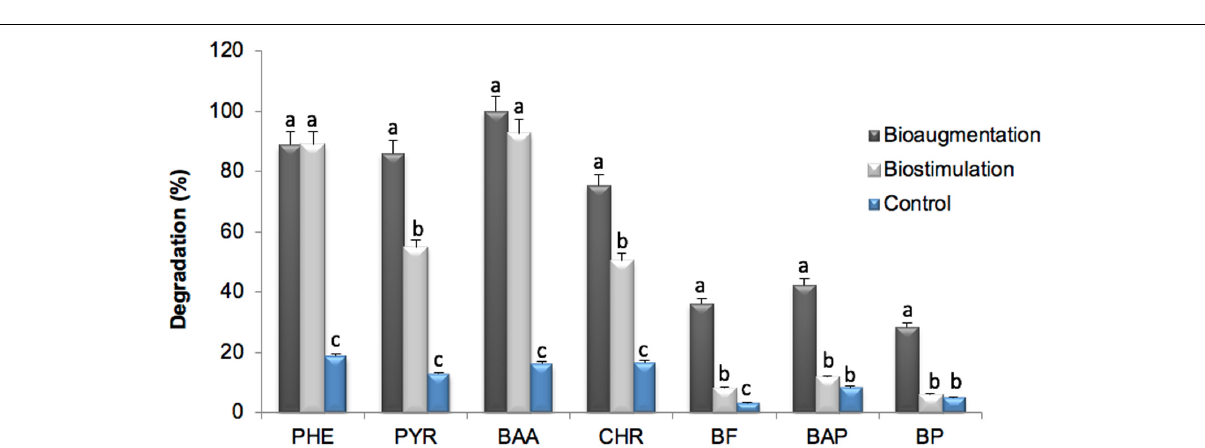
FIGURE 3 | Degradation of PAHs (%) after 120 incubation days in experimental conditions. (Mean values ± SD for three replicates). B, Bioaugmentation; BS, Biostimulation; PHE, (phenanthrene, three rings PAH); PYR, (pyrene, four rings PAH); BAA, [benzo(a) anthracene, four rings PAH]; CHR, (Chrysene, four rings PAH); BF, [benzo(b,k)fluoranthene, five rings PAH]; BAP, [benzo(a)pyrene, five rings PAH]; BP, [benzo(g,h,i)perylene, six rings PAH]. Different lower-case letters within treatments indicate the occurrence of significant differences between them ( P < 0.05). Anthracene was at very low values, below the detection limit (i.e., 2 mg Kg - 1 ), reason why it has not been included in the